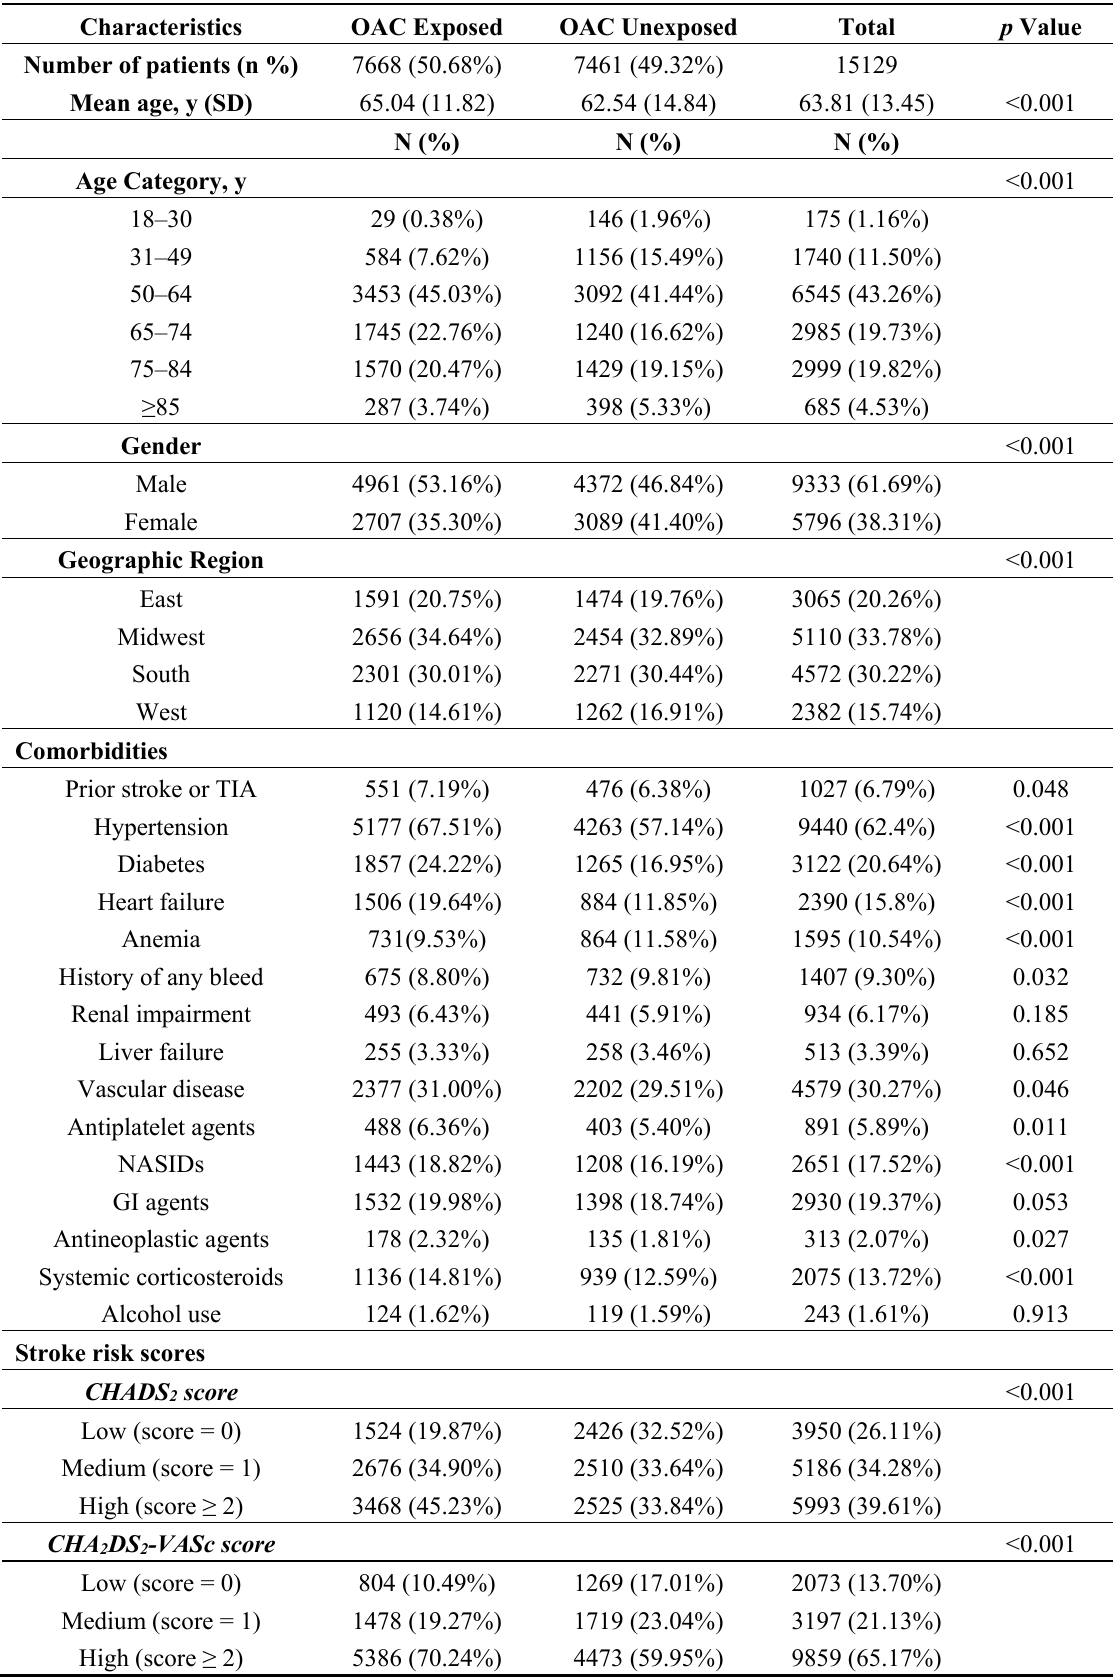
Table 1. Demographics characteristics of the study